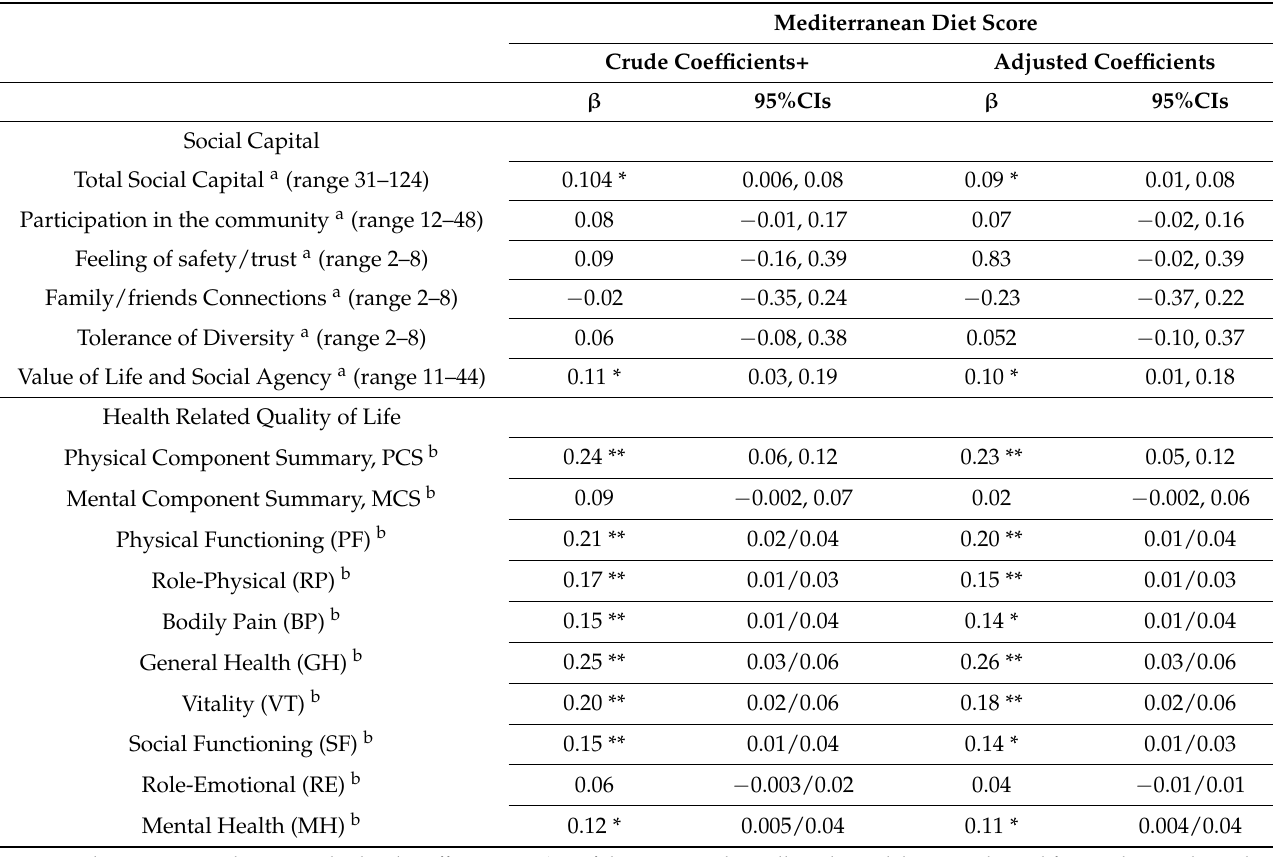
Table 3. Relationships of Social Capital, Physical Health and Mental Health (SF36) on adherence to Mediterranean Diet using multivariable linear regression models, ( n =